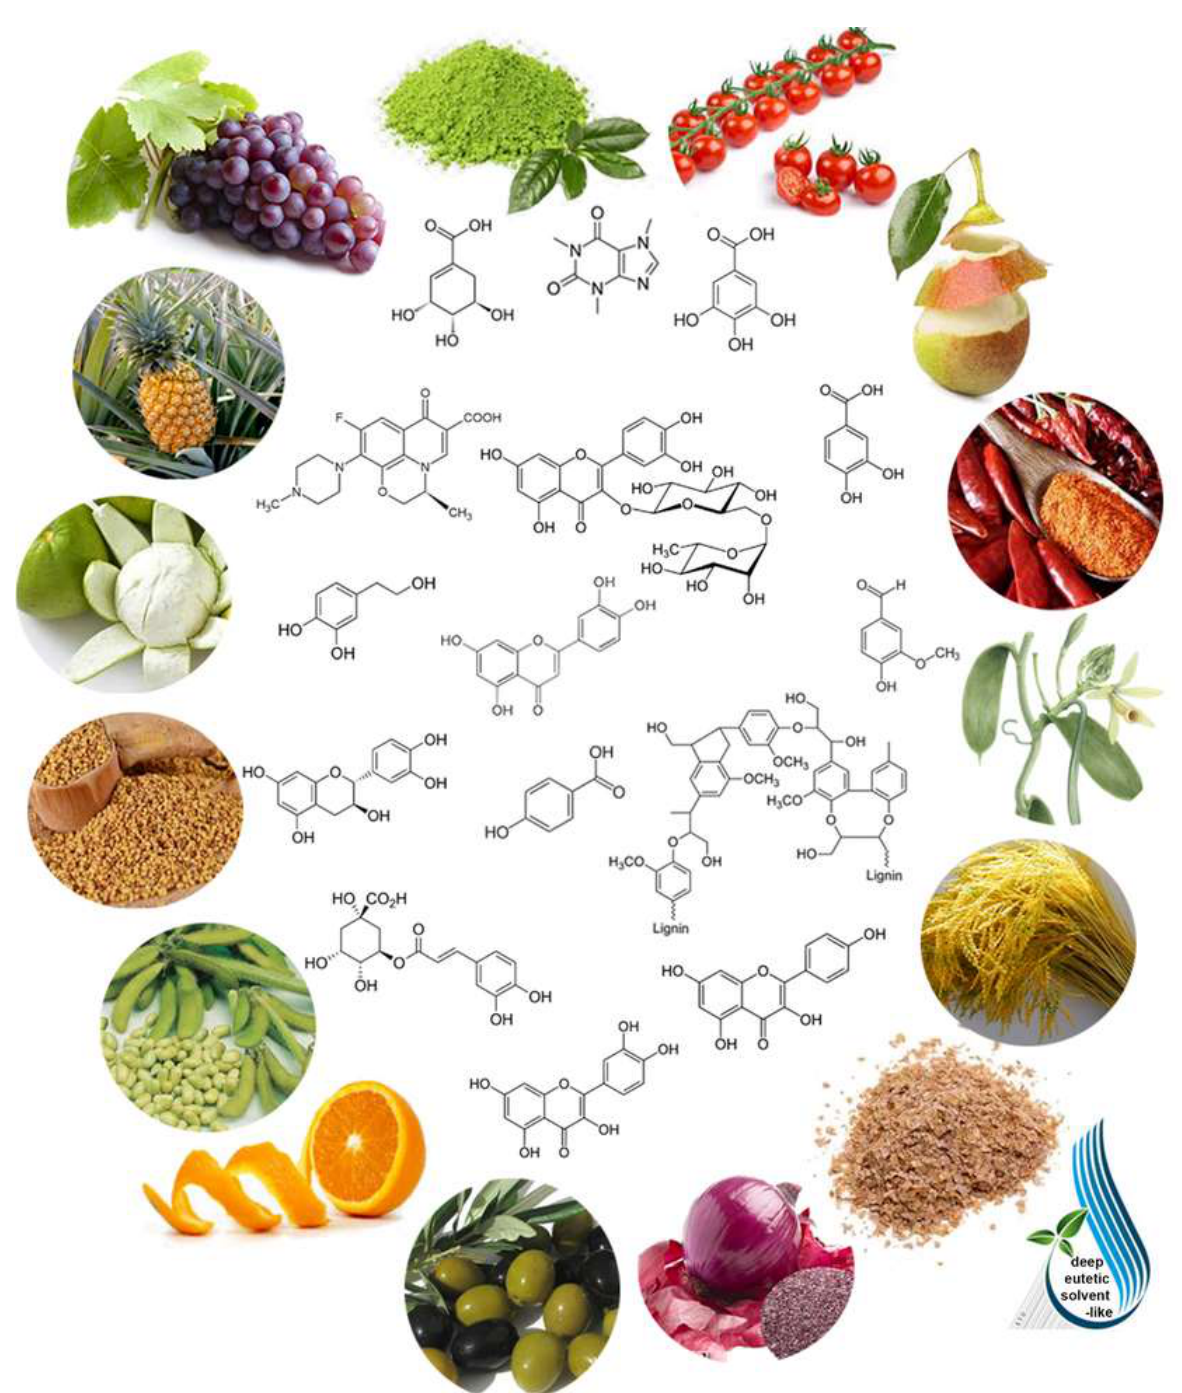
Figure 2. Extraction of lignocelluloses biomass using DES-like